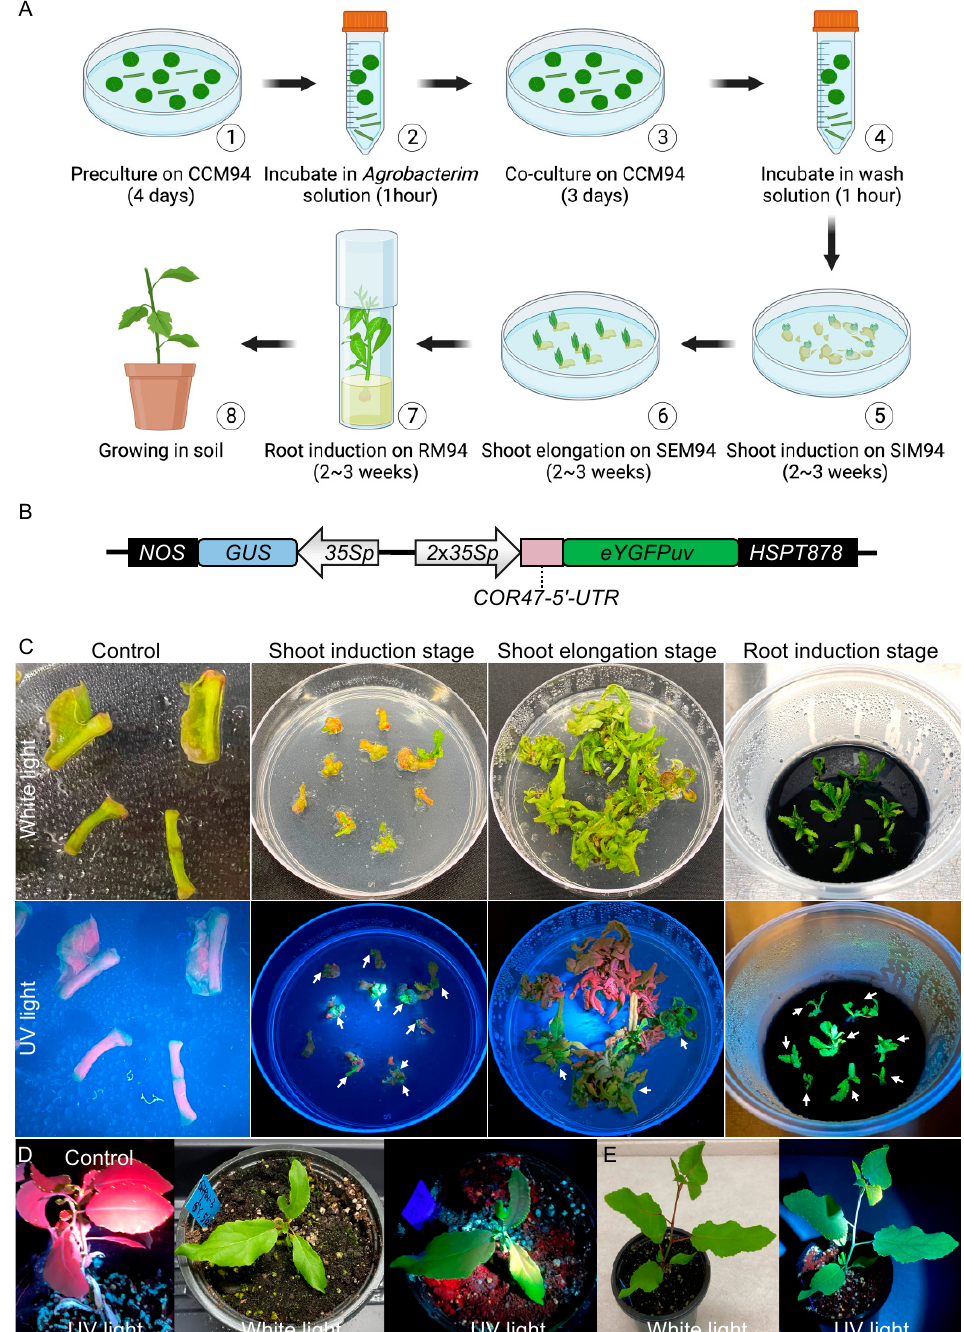
Figure 1. eYGFPuv-assisted plant transformation in Populus deltoides . ( A ) The procedures of tissue- culture-based and Agrobacterium -mediated plant transformation in Populus deltoides . ( B ) Illustration of eYGFPuv/GUS dual reporter vector (pAXY0003). 35S; Cauliflower mosaic virus ( CaMV ) 35S promoter; NOS , the nopaline synthase terminator; HSPT878 , HSPT878 terminator. ( C ) Visualization of eYGFPuv in different stages of plant transformation under UV light. White arrows indicate transgenic shoots with green fluorescence. Control indicates the transformation using a vector without the eYGFPuv gene. ( D ) Visualization of eYGFPuv in poplar plants, six weeks in soil. Control indicates the wild-type plant under UV light. ( E ) Visualization of eYGFPuv in poplar plants, nine weeks in